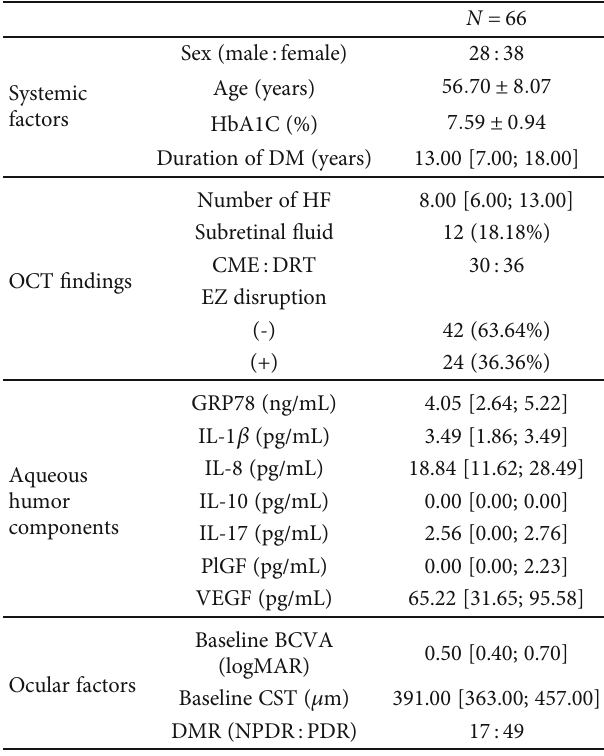
Table 1: Demographics and clinical characteristics of the center- involving diabetic macular edema